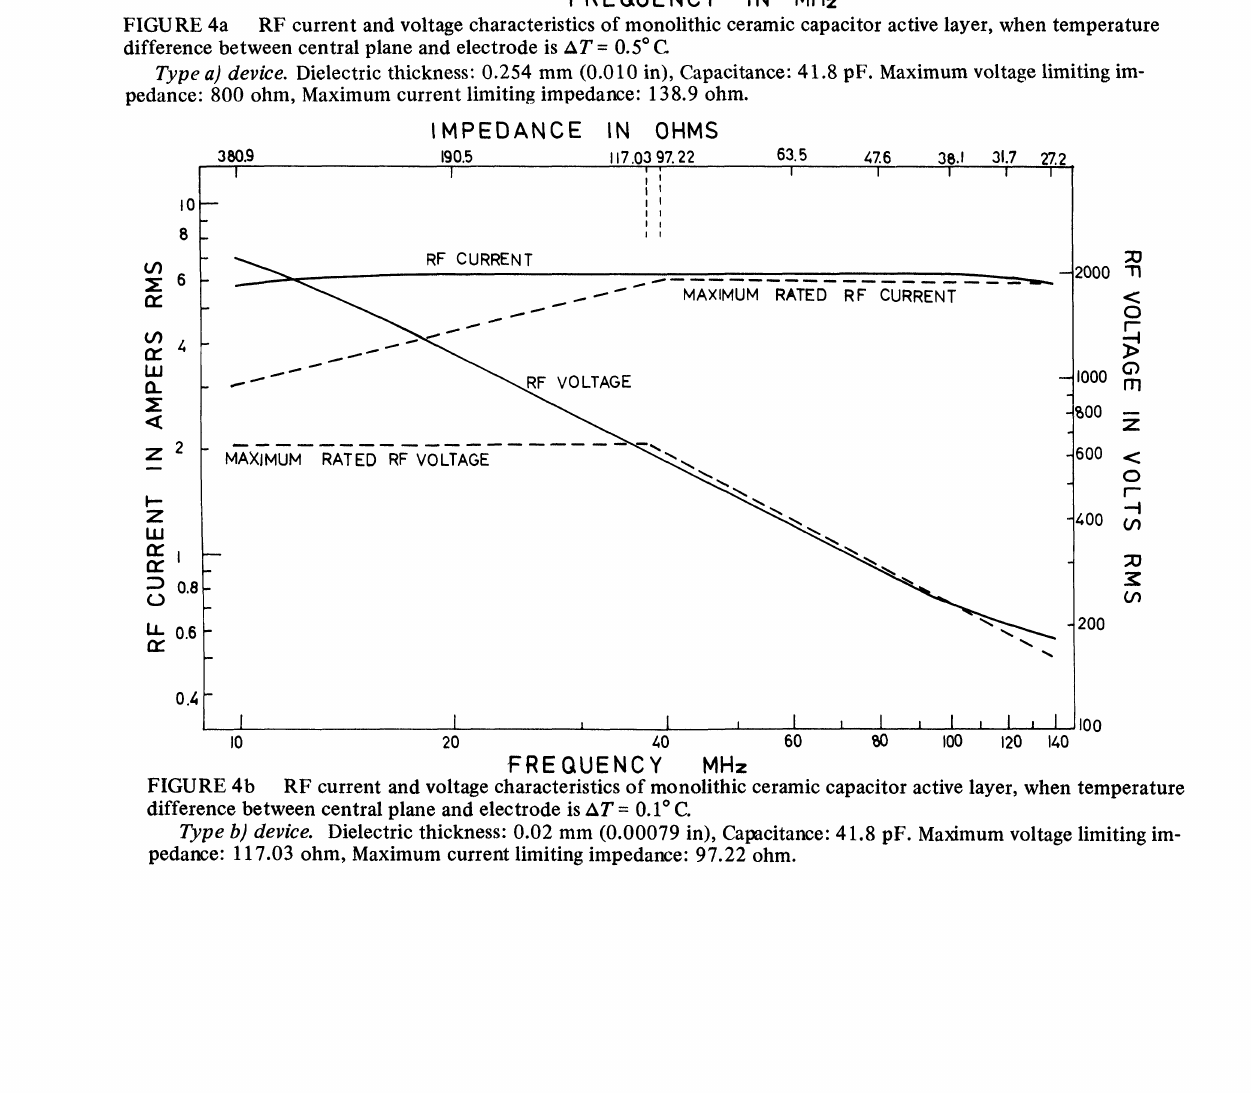
FIGURE 4a RF current and voltage characteristics of monolithic ceramic capacitor active layer, when temperature difference between central plane and electrode is AT 0.5 C Type a) device. Dielectric thickness: 0.254 mm (0.010 in), Capacitance: 41.8 pF. Maximum voltage limiting im- pedance: 800 ohm, Maximum current limiting impedance: 138.9 ohm.